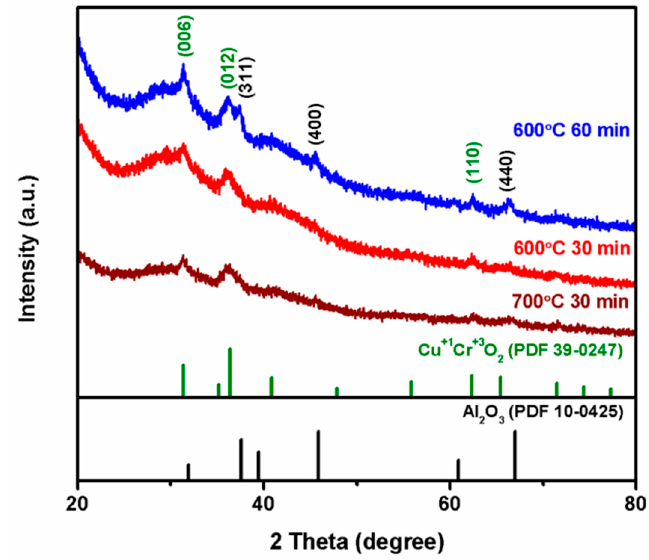
Figure 5. XRD patterns of Al 2 O 3 microfibers with copper chromium oxide deposited on the surfaces after annealing at 600 °C and 700 °C in vacuum.